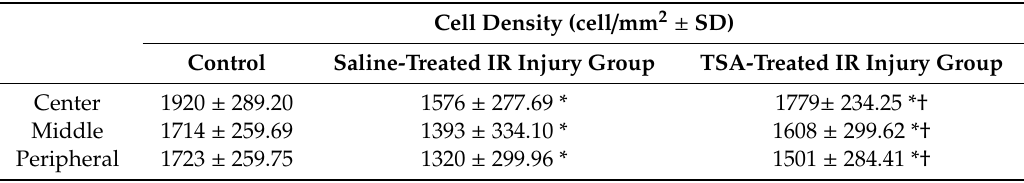
Table 1. The e ff ect of TSA on retinal ganglion cell survival in ischemic